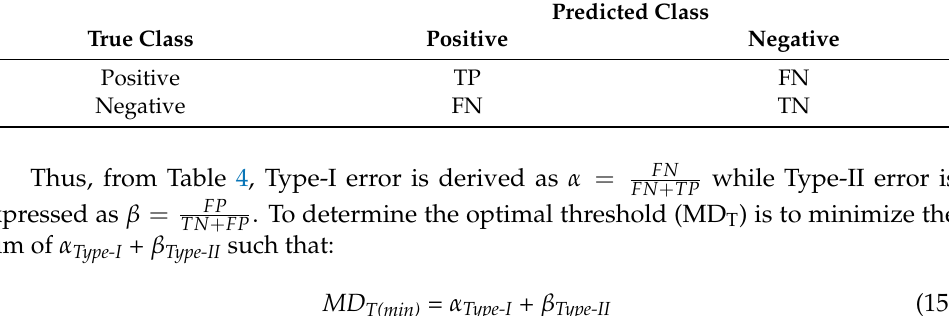
Table 4. A typical Confusion Matrix.